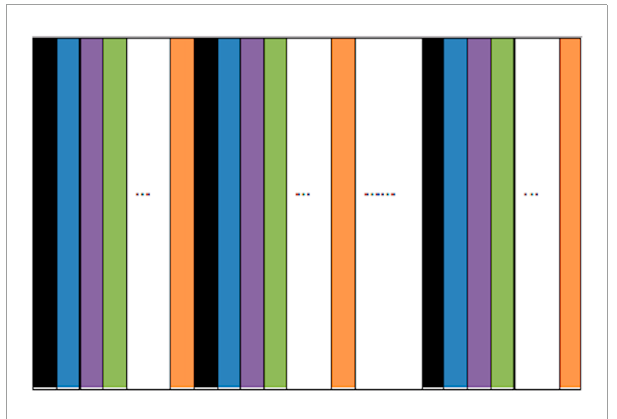
FIGURE 5 Difference degree amplitudes (unitless) of several gravity field models (GOCO01S and IGGT_R1C) w.r.t. EGM2008 and that of IGGT_R1_test w.r.t. its a priori model EIGEN-5C. The degree amplitudes of the EGM2008 model (black) are shown for